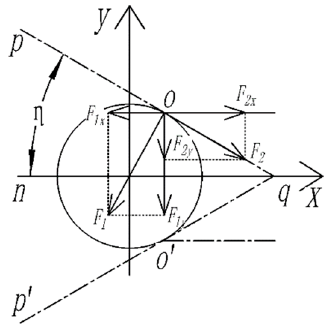
Figure 5. Effective feeding conditions of clamping device.